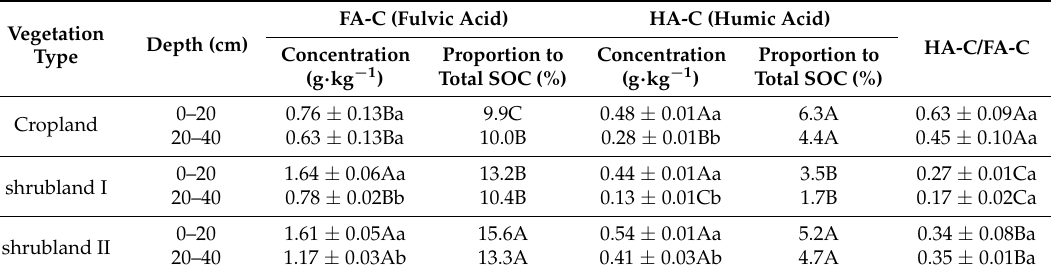
Table 2. Soil organic carbon fraction concentrations and their proportion to total